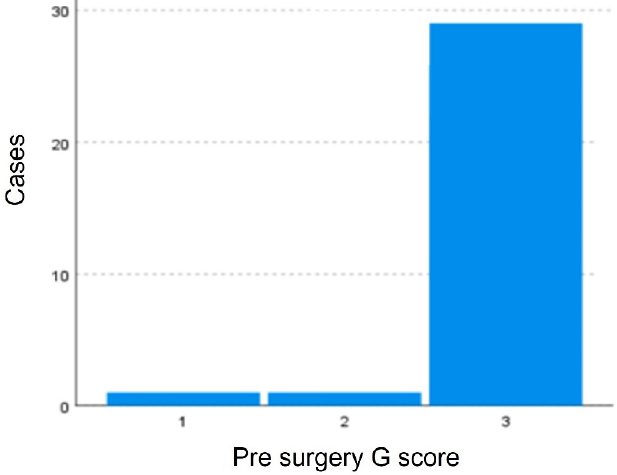
Figure 8. Distribution of patients according to the G scale. Greater clustering of pre-surgical patients with high degrees of dysphonia (G3) is observed.